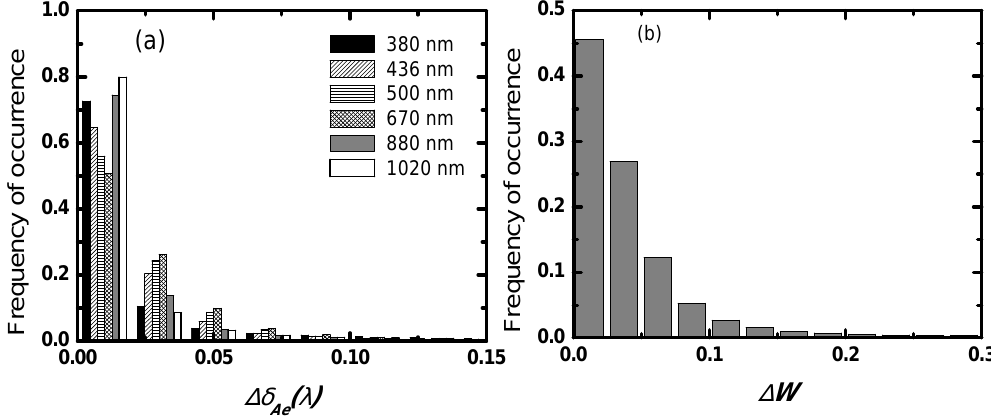
Figure 2: Frequency histograms of the absolute differences between two consecutives values of: (a) aerosol optical depth at each wavelength, ∆ δ Ae ( λ ) , and (b) precipitable water vapour, ∆ W .